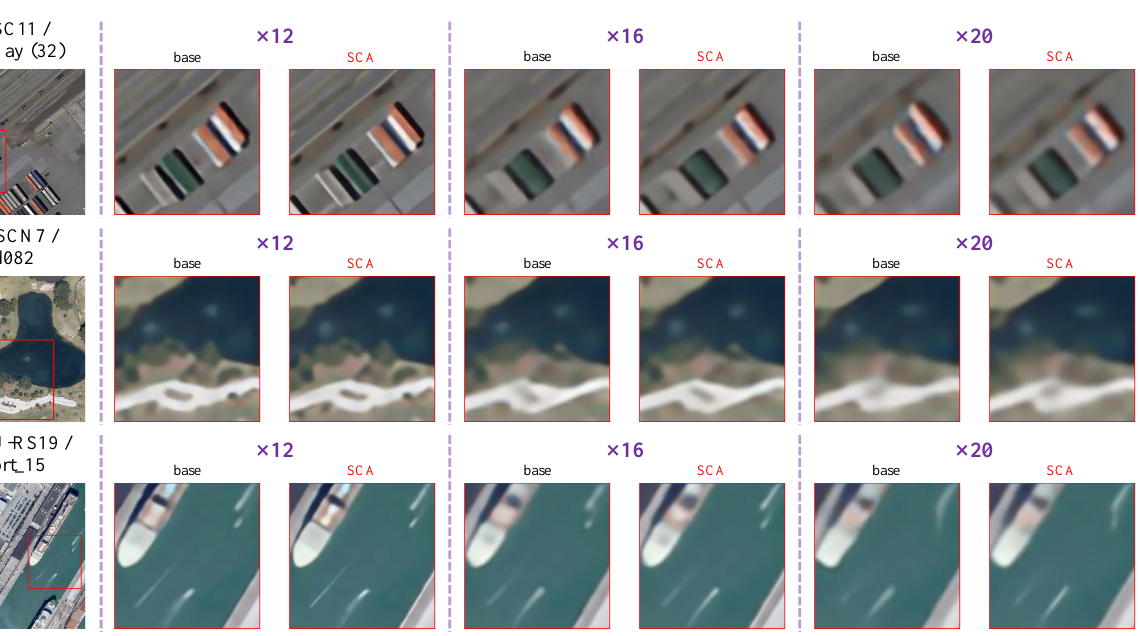
Figure 8. Enhancement brought about by SCA at scale factors of 12, 16, and